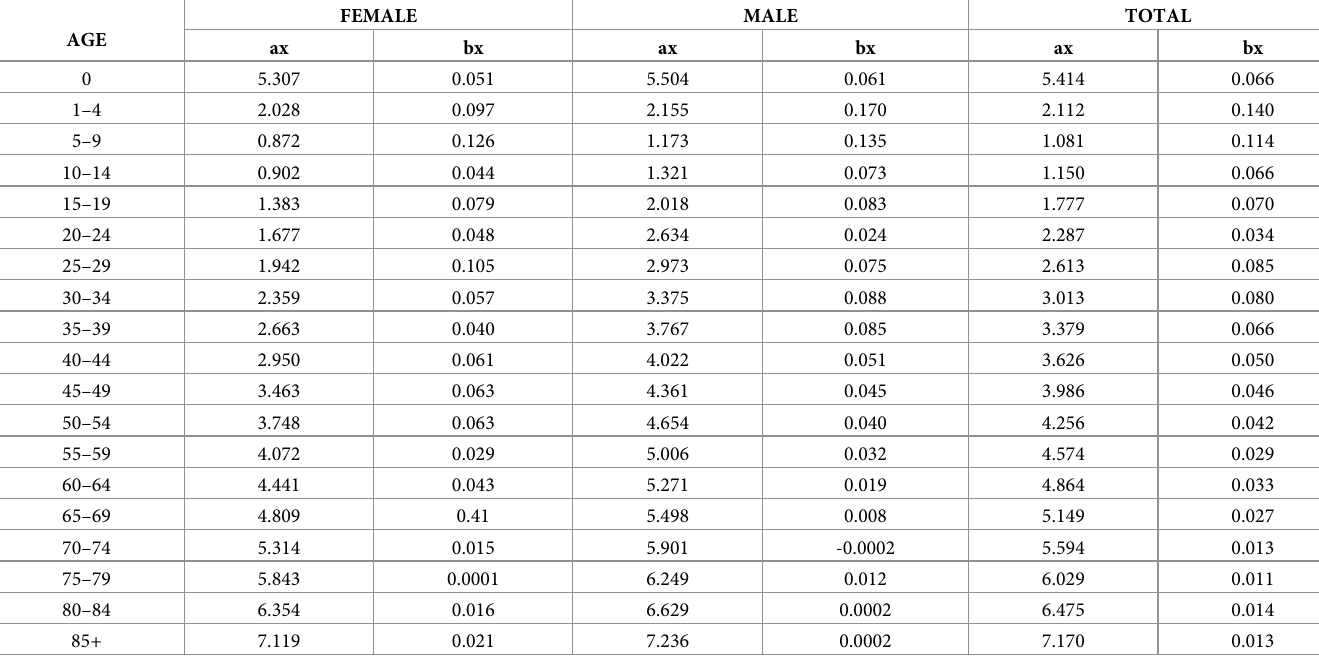
Data source: Ministry of Health of Cabo